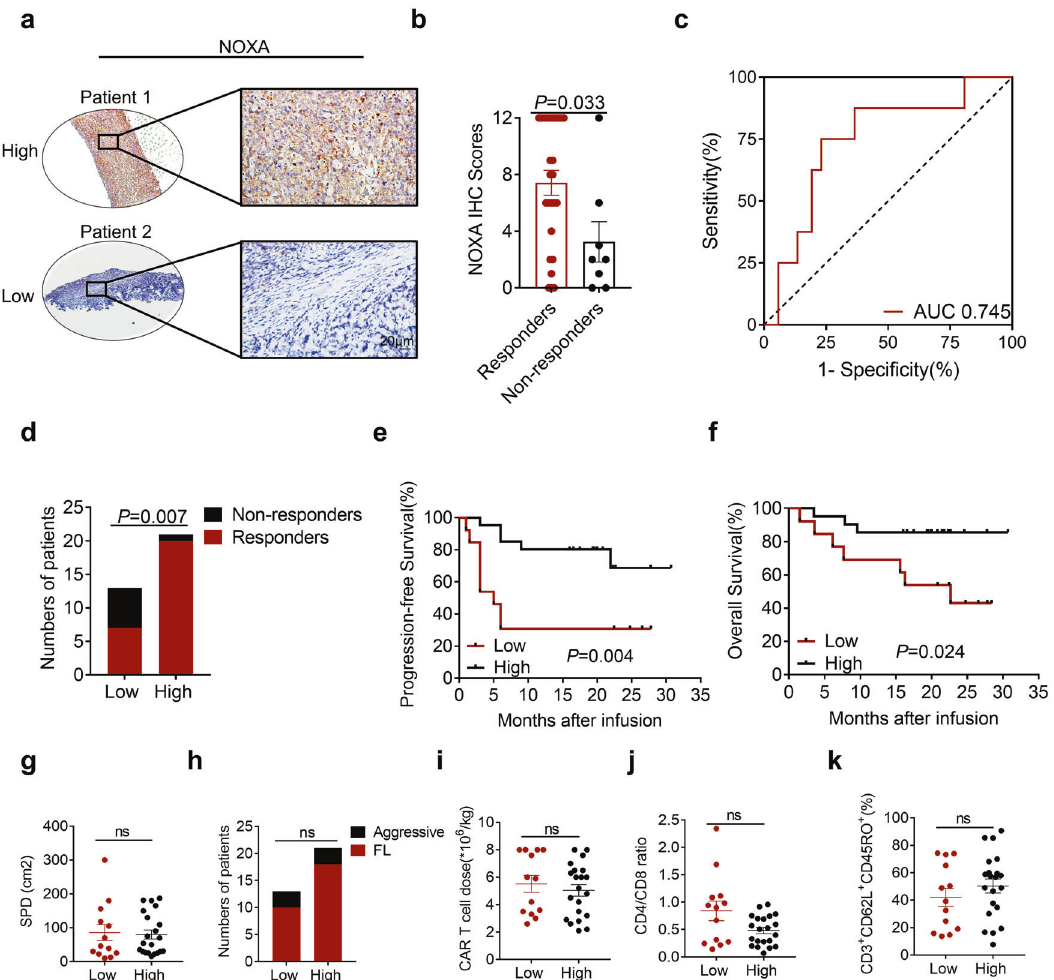
Fig. 5 NOXA expression is related to clinical outcomes after CAR T-cell infusion. a Representative images of immunohistochemical (IHC) staining for high and low NOXA expression in R/R B-cell lymphoma before treatment with tandem CD19/CD20 CAR T cells. The outlined areas in the left images are magni fi ed on the right. Scale bars, 20 μ m. b NOXA expression scores by IHC in responders and non-responders. A two- tailed Student ’ s t test was used to analyze the differences between two groups. c The ROC curve of NOXA IHC scores in responders and